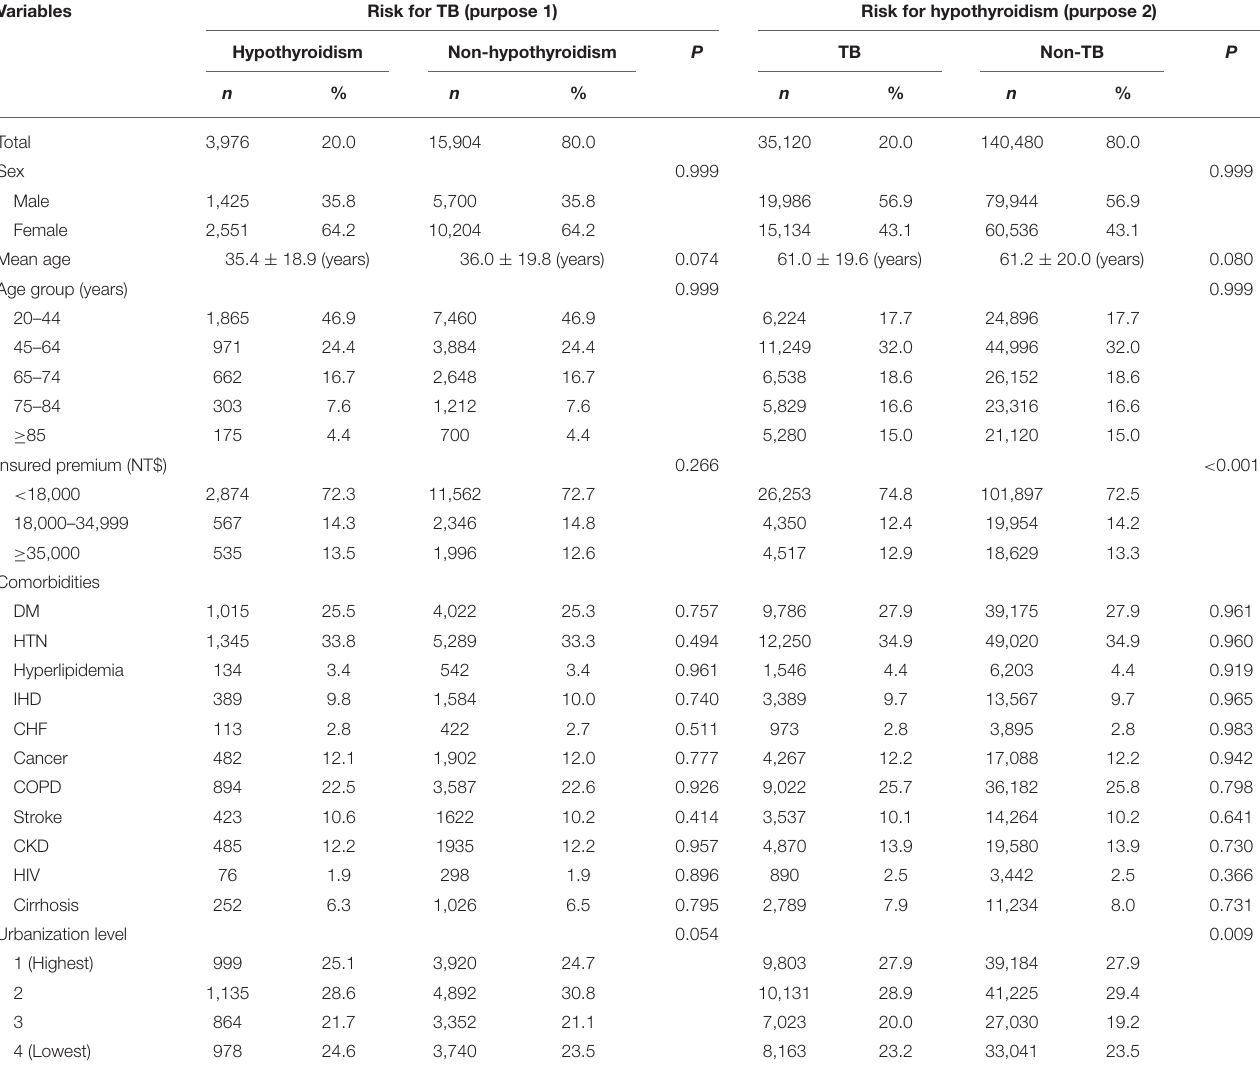
TABLE 1 | Baseline characteristics of study